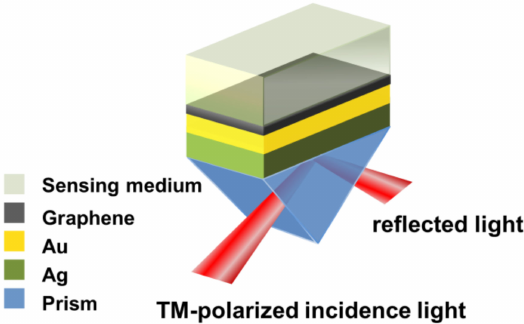
Figure 1. Schematic diagram of the proposed